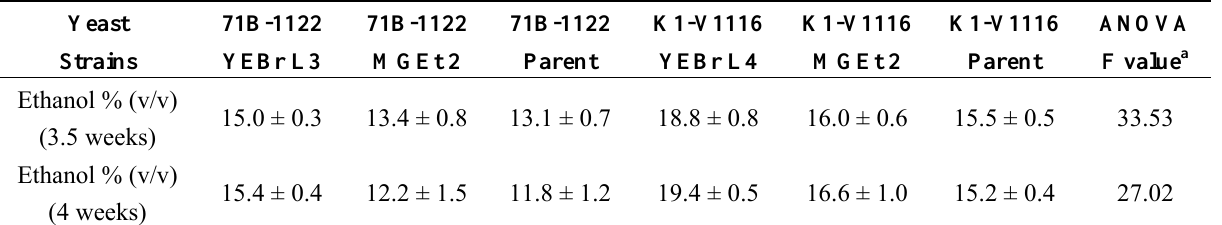
Fermentation was carried out in batch culture containing 20% glucose in minimal media. Samples were collected for analysis only after most of the sugar was consumed by the yeast i.e. when the sugar test indicated trace or less than 1% sugar. The theoretical yield for converting 50 mL of 20% glucose (10 grams) to ethanol is about 13% ethanol. Table 2. Average concentration of ethanol produced in “teased” fermentation.